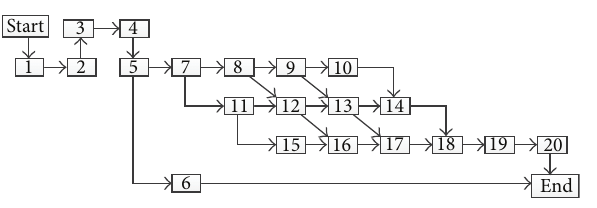
Figure 3: Construction procedure of the building example. 1: clear